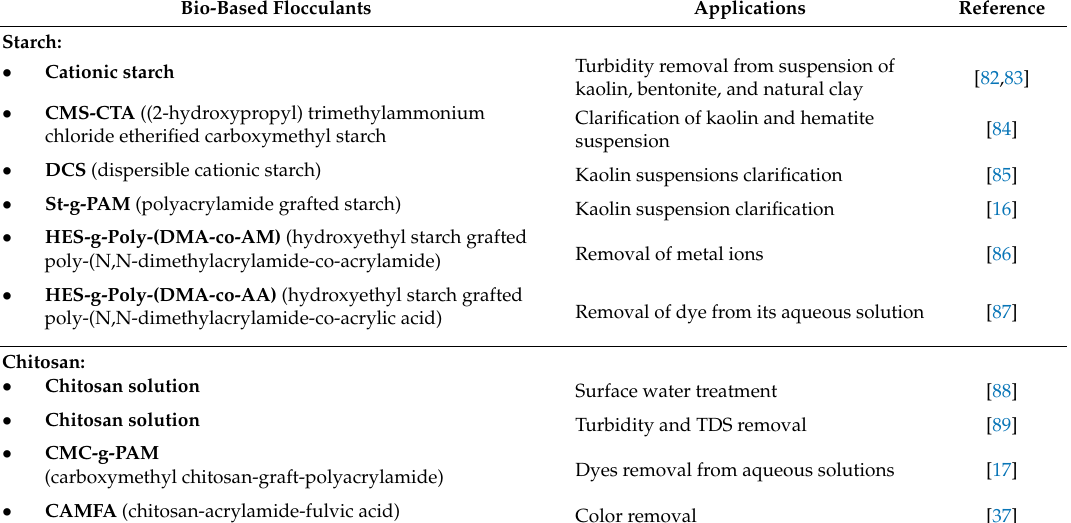
Table 1. Polysaccharide flocculants used in water and wastewater